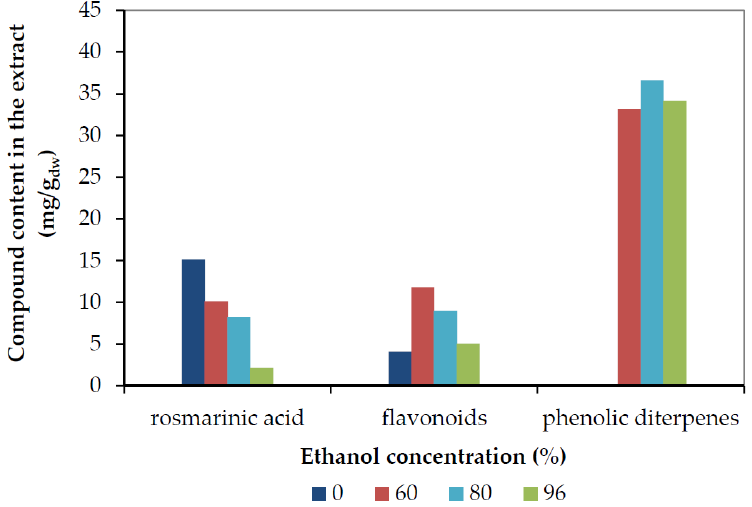
Figure 6. The final recovery of rosmarinic acid, total flavonoids (expressed as mg Que/g dw ), and phenolic diterpenes (sum of carnosic acid plus carnosol) as a function of ethanol concentration. Molecules 2020 , 25 , x